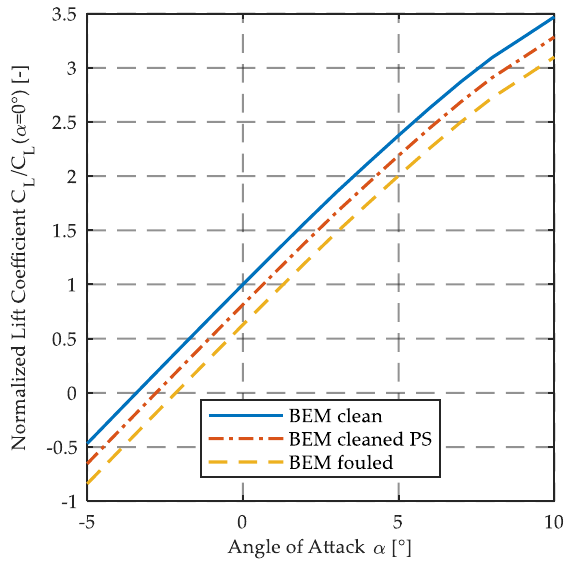
Fig. 10 Variation of the hydrofoil condition (clean, cleaned PS, fouled) and its effect on the normalized lift as function of the angle of attack